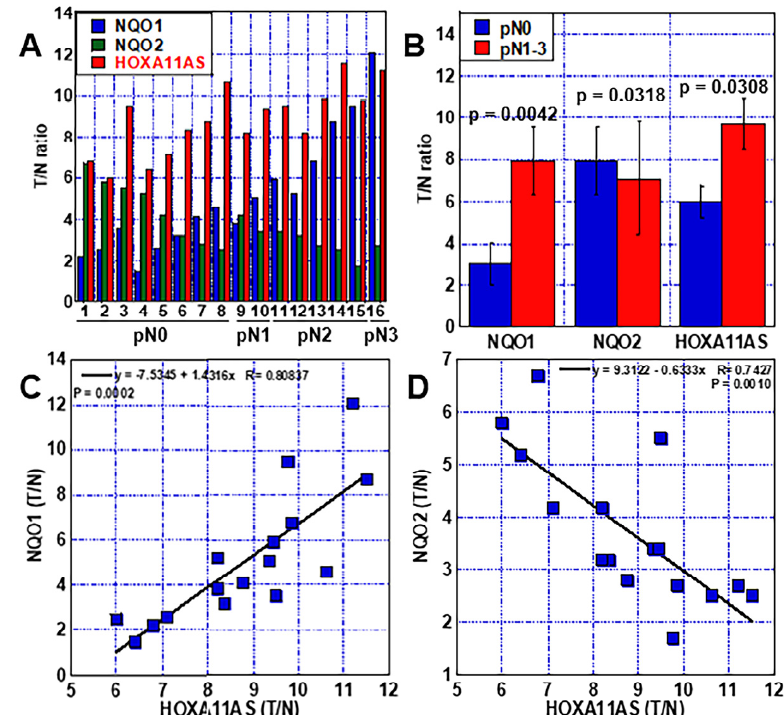
Figure 1. Relationship between HOXA11-AS and NQO1 or NOQ2 in 16 OSCC cases. ( A ) Relative mRNA expression of NQO1 , NQO2 , and HOXA11-AS . ( B ) Relationship between nodal metastasis and expression (T/N ratio) of NQO1 , NQO2 , and HOXA11-AS . Statistical differences were calculated by unpaired t -test with Welch correction. ( C ) Relationship of expression (T/N ratio) between HOXA11-AS and NQO1 . ( D ) Relationship of expression (T/N ratio) between HOXA11-AS and NQO2 . Regression analysis was performed using Pearson’s r-test. Error bars indicate the SD calculated using Student’s t -test from three independent trials. OSCC, oral squamous cell carcinoma; T/N ratio, tumor-to-normal ratio; NQO1 , NAD(P)H: quinone oxidoreductase 1; NQO2 , NRH: quinone oxidoreductase 2; pN0, no nodal metastasis; pN1, metastatic node <3 cm; pN2, metastatic node 3–6 cm; pN3, metastatic node >6 cm or >3 cm with extranodal invasion [13].